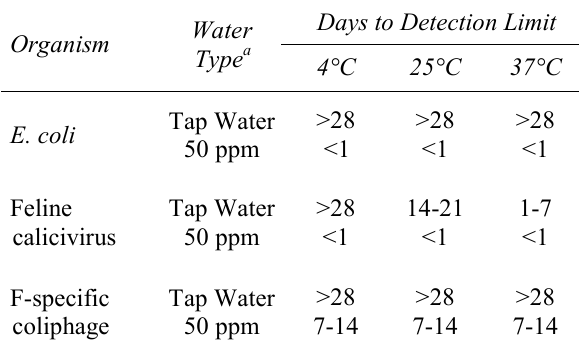
Table 1: Days to detection limit by